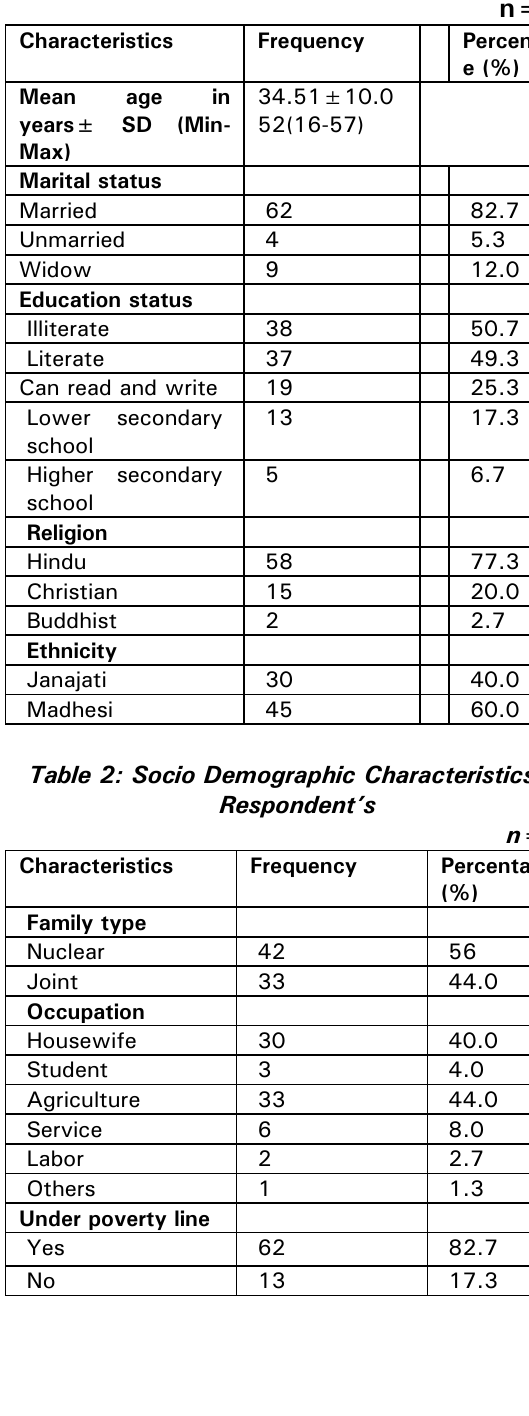
Table 1: Socio Demographic Characteristics of